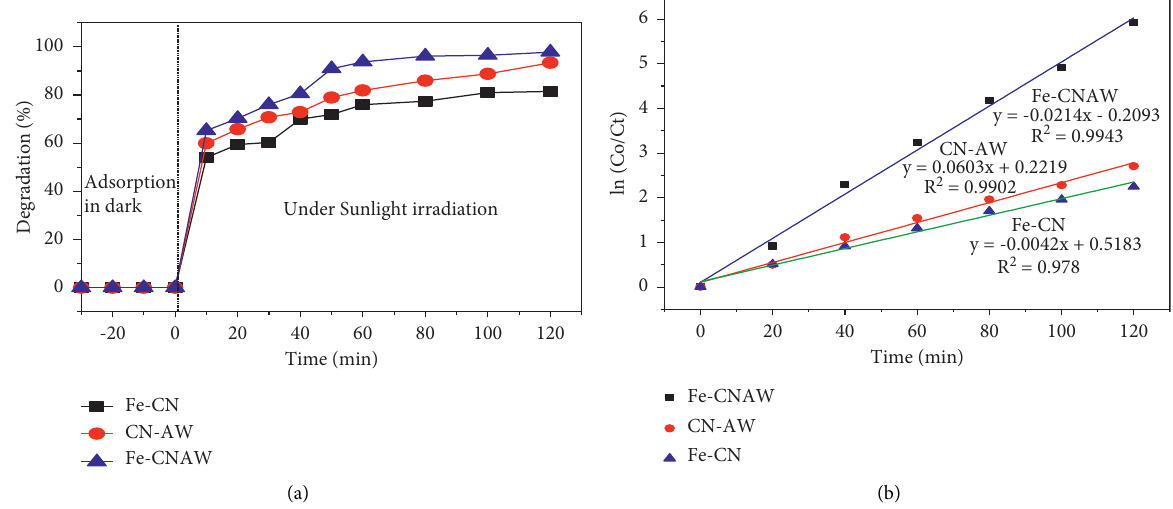
Figure 8: (a) RhB degradation by all catalysts as a function of time under sunlight and (b) first-order kinetic model fitting. Table 1: Correlation coefficients ( R 2 ) and kinetic parameters for RhB (Co � 10 ppm) degradation. Optimized reaction conditions First-order Nanocomposites